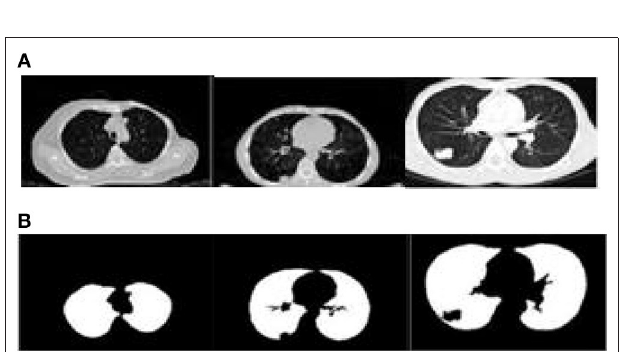
FIGURE 3 | Comparison of the effect of lung image segmentation before and after. (A) Presegmentation lung images. (B) Lung images postsegmentation by proposed algorithm.